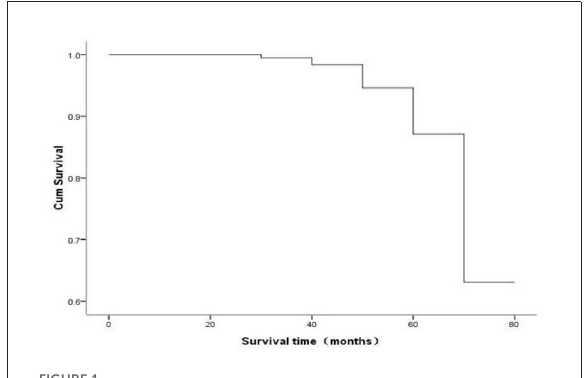
FIGURE1 The OS analysis of all patients showed a median survival of 70 months.